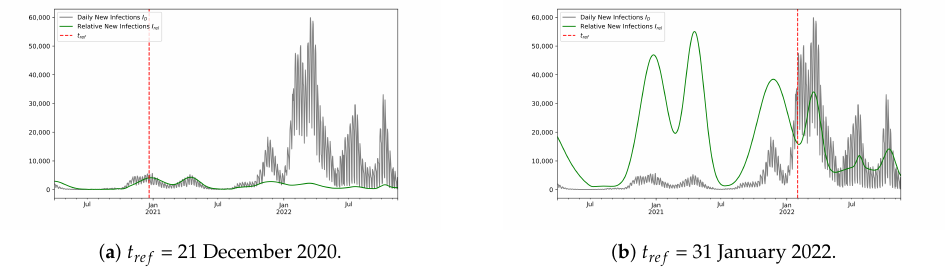
Figure 5. Estimates of relative new infections I rel p t , t ref q . The grey line indicates the daily new infections, the dashed red line indicates the chosen reference date, and the green line indicates relative new infections corresponding to this reference date. ( a ): Reference date t ref = 21 December 2020. ( b ): Reference date t ref = 31 January